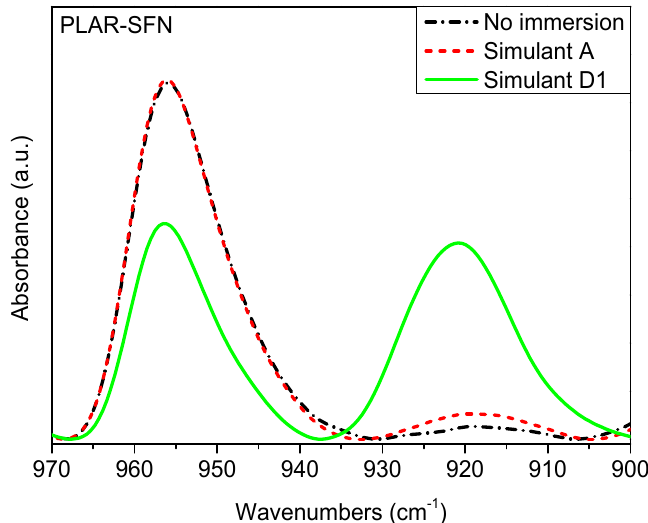
Figure 6. ATR-FTIR spectra of the recycled poly(lactic acid) and silk fibroin nanoparticle nanocom- posite (PLAR–SFN) before and after immersion in the different food simulants. Region between 900 and 970 cm − 1 .